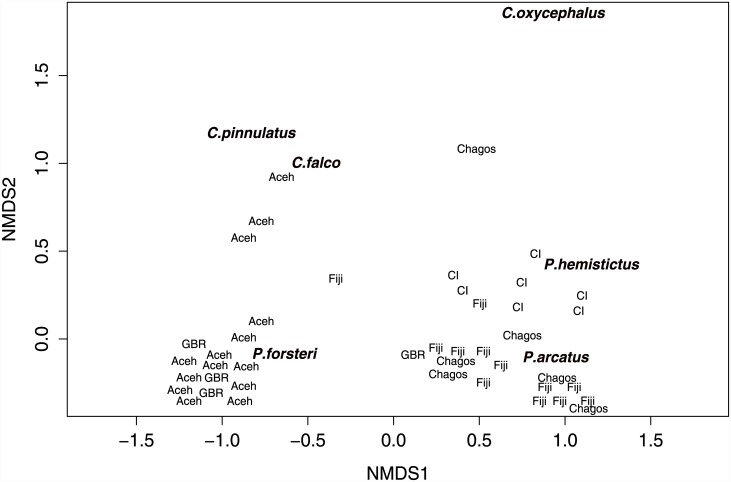
Multidimensional-scaling plot (MDS) of reefs within locations based on hawkfish community composition.Each location point represents a reef within the location. Location abbreviations: CI = Christmas Island, and GBR = Great Barrier Reef. Position of hawkfish species represents correlations between fish assemblages and reefs based on habitat variables. Plot stress = 0.043.